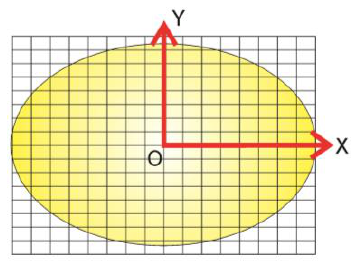
Figure 1. Footprint divided into several same bins.